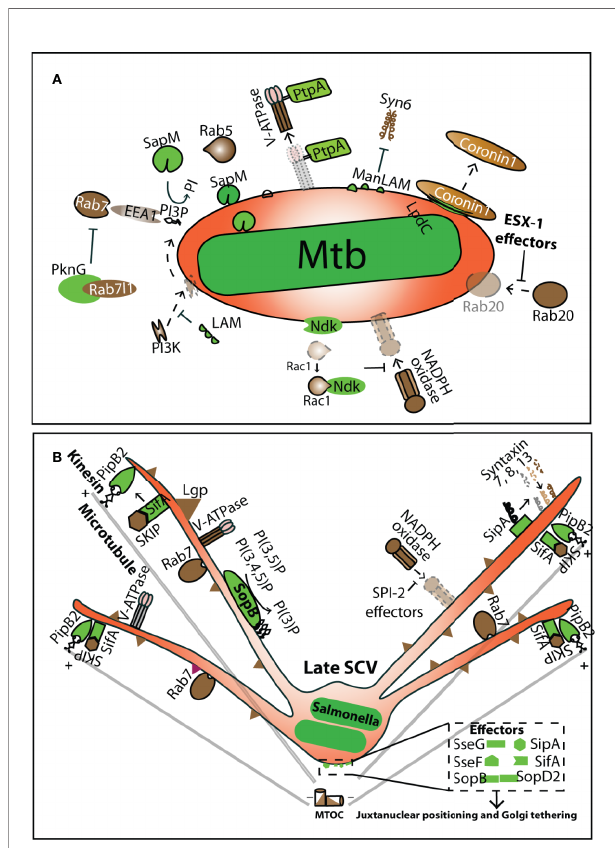
FIGURE 3 | Manipulation of lysosomal traf fi cking by Pathogen containing vacuoles. (A, B) summarizes some of the known molecular events in the interface of Mtb containing vacuole (MCV) and Salmonella containing vacuole (SCV), respectively. Pathogen effectors (shown in green) target different host factors (brown) and in fl uence their recruitment or release on the respective PCV ’ s. Arrows indicate the nature of interactions. Dotted arrows show the processes that occur on a normal phagosome but are manipulated on the